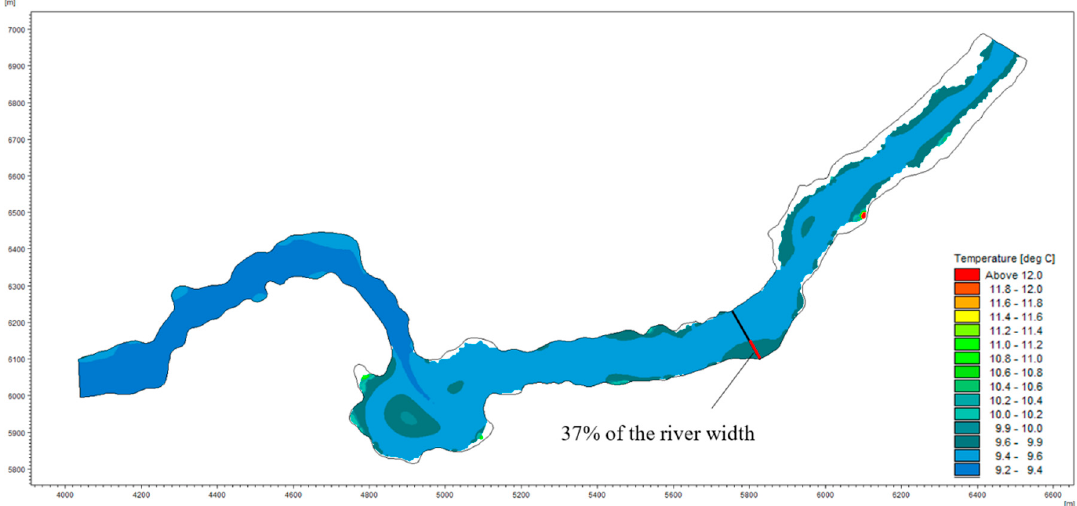
Figure 8. Distribution map of the water temperature field in the river section.